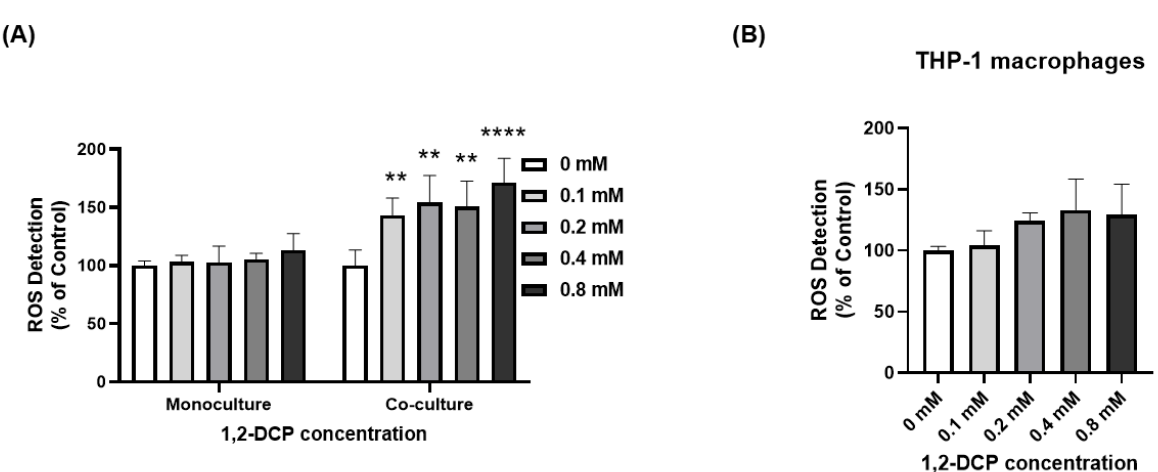
Figure 7. Effects of 1,2-DCP on ROS production, as assessed by DCFDA assay. ( A ) monocultures of MMNK-1 cells and MMNK-1 cells co-cultured with THP-1 macrophages. ( B ) THP-1 macrophages exposed to 1,2-DCP at 0, 0.1, 0.2, 0.4, and 0.8 mM for 24 h. Percentages are in relation to 0 mM 1,2-DCP group. Data are mean ± SD, n = 3. ** p < 0.01, **** p < 0.0001 compared with the control group (0 mM), by two-way ANOVA ( A ) and one-way ANOVA ( B ) followed by Dunnett’s multiple comparison test. Two-way ANOVA showed a significant interaction between “1,2-DCP” and “macrophages”. Table 2. Effects of 1,2-DCP on cytotoxicity and oxidative stress.